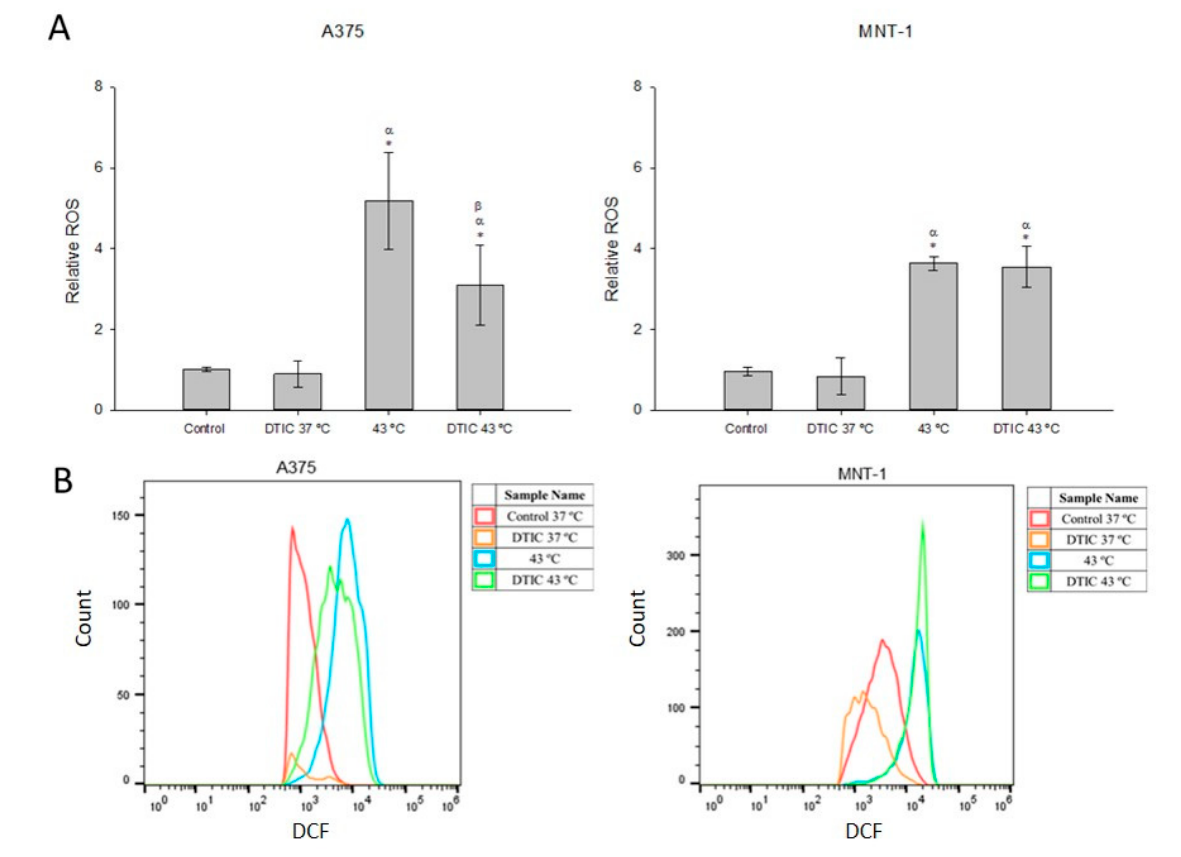
Figure 6. Effects of DTIC combined with hyperthermia on intracellular ROS production. Cells were exposed to 43 °C for 30 min and 5.5 μ g/mL or 115 μ g/mL of DTIC for 48 h, in case of A375 or MNT-1 cells, respectively. ( A ) Intracellular ROS relative abundance of A375 and MNT-1 cells; ( B ) representative histograms of the abundance of intracellular ROS of both cell lines assessed by the DCF fluorescence intensity (arbitrary units). Data shown are the mean values ± standard deviation of two independent experiments, with three technical replicates each, and each replicate with at least 5000 events. * indicates statistical significance in comparison to the control 37 °C, α indicates statistical significance in comparison to the respective condition at 37 °C, and β indicates statistical significance of the conditions with hyperthermia in comparison to hyperthermia alone ( p < 0.05).